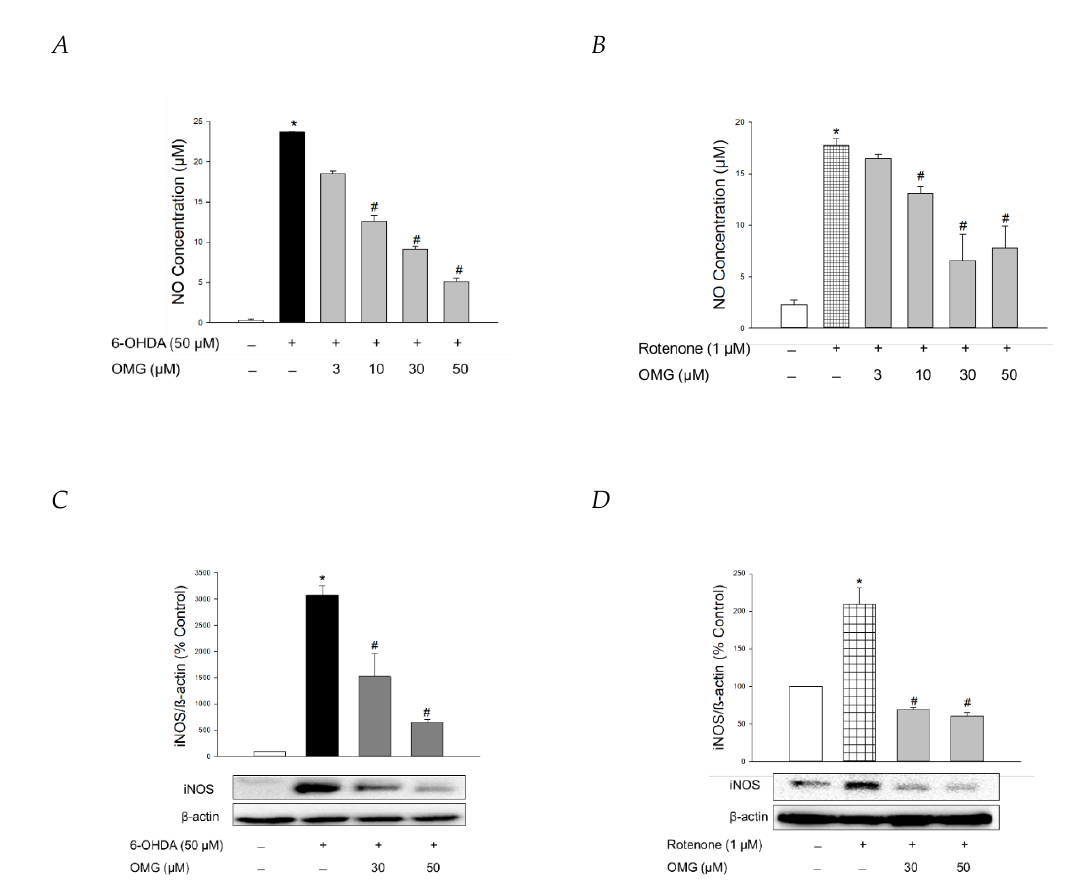
Figure 6. Inhibition of NO production and iNOS expression by OMG in 6-OHDA- or rotenone-treated PC12 cells. ( A , B ) PC12 cells were pretreated with OMG at the indicated concentrations for 4 h and subsequently exposed to ( A ) 6-OHDA or ( B ) rotenone for 24 h. Control cells were treated with the vehicle alone. NO production was evaluated by Griess assay, as described in the Materials and Methods section. NO concentrations were determined using the standard curve generated simultaneously. ( C , D ) Levels of iNOS expression were analyzed by western blotting, as described in the Materials and Methods. Band intensities were quantified by densitometric analyses and normalized to β -actin. Representative blots are shown. Data are displayed as the mean ± SEM from three independent experiments. *, p < 0.05 and # , p < 0.05 vs. vehicle-treated control and 6-OHDA- or rotenone-treated cells, respectively. NO, nitric oxide; iNOS, inducible NO synthase; OMG, omarigliptin; 6-OHDA, 6-hydroxydopamine.